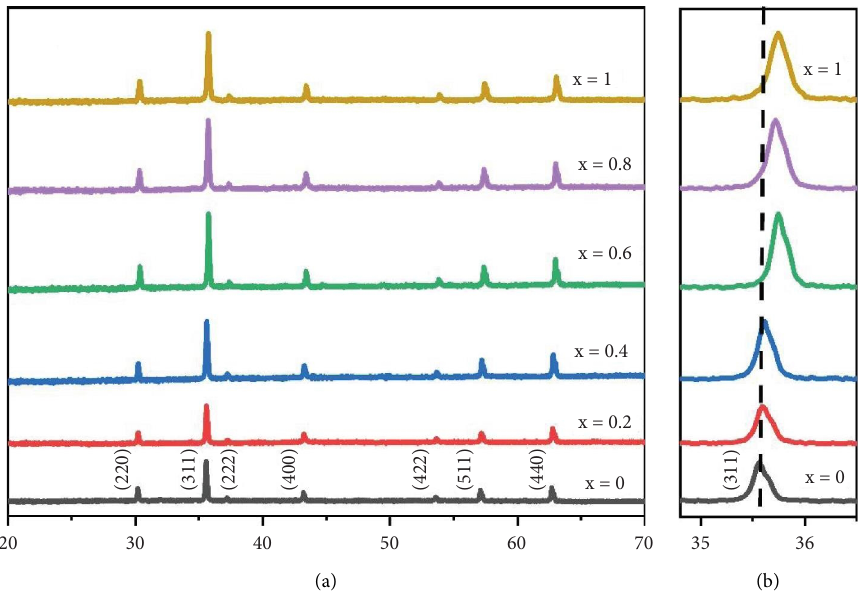
� 0.0 ≤ x ≤ 1.0) calcinated at 800 ° C along with the magnifed view of 1 − x Ni x Fe 2 O 4 (where x